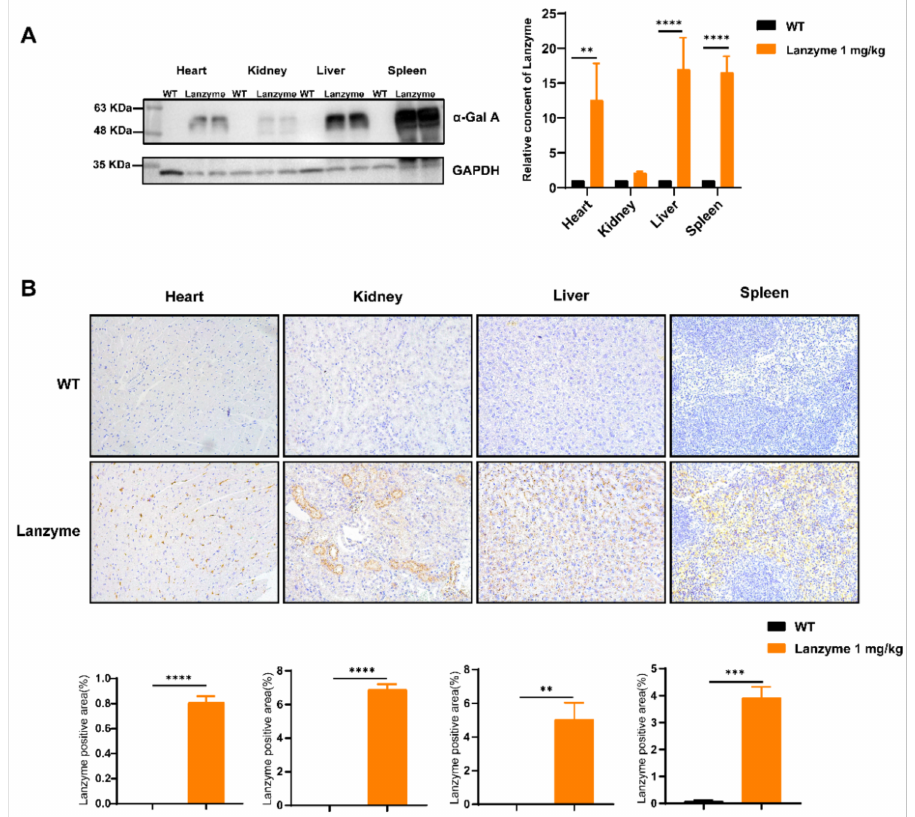
Figure 3. Tissue and cellular distribution of infused Lanzyme injected into WT mice. Eight-week- old male WT mice ( n = 4) were administered an intravenous bolus injection of 1 mg/kg Lanzyme. Tissues were collected at 24 h after administration. Western blotting verified the uptake of Lanzyme in mouse tissues after administration ( A ), and IHC staining was conducted on paraffin sections using an antihuman α -Gal A antibody ( B ). Western blotting and IHC of Lanzyme in WT mice tissue semi-quantitative analyses were conducted using Image J software. * Comparison between WT mice, the uptake and distribution of Lanzyme in WT mices tissue. ** p < 0.01, *** p < 0.001, **** p <